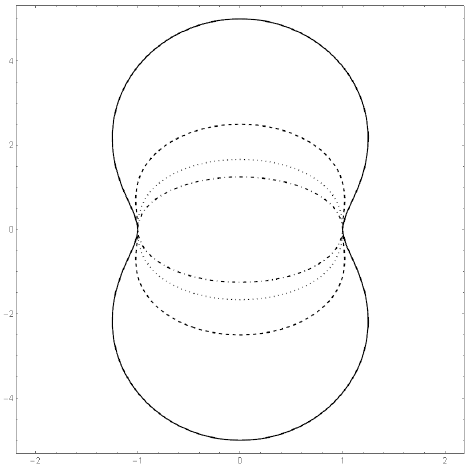
Figure 3. Plot of the boundaries of K in the cases a = − 0.8 (solid line), a = − 0.6 (dashed line), a = − 0.4 (dotted line), a = − 0.2 (dashed/dotted